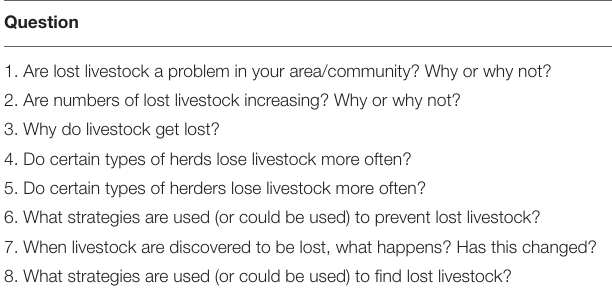
TABLE 1 | Questions used in questionnaire-based interviews.